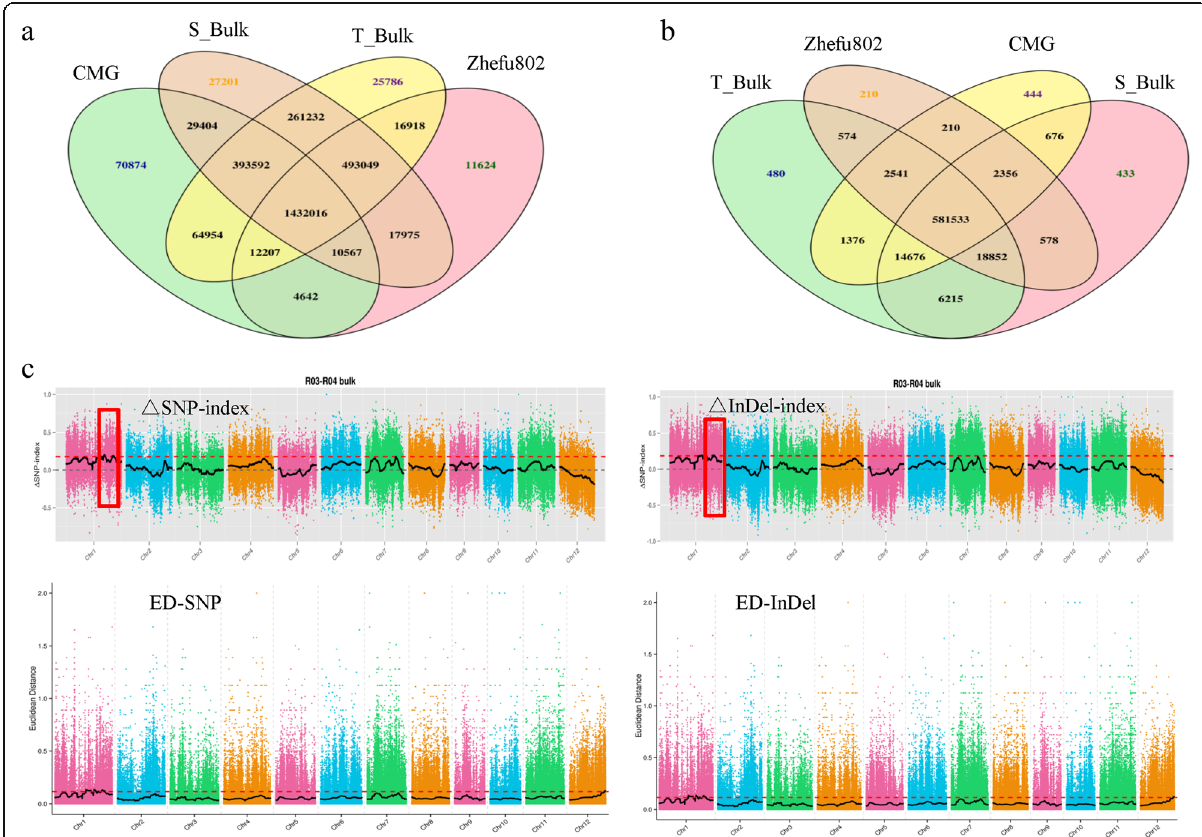
Fig. 2 Constructing the extremely sensitive (S_bulk) and tolerant (T_bulk) salt bulks and BSA-seq analysis for both parents, CMG and Zhefu802, and the two extreme bulks. a : The frequency distribution of the germination rate in more than 1000 F 2:3 lines from CMG and Zhefu802; b : Venn diagram of the number of SNPs in CMG, Zhefu802, S_bulk, and T_bulk; c : Venn diagram of the number of small InDels in CMG, Zhefu802, S_bulk, and T_bulk; d : the distribution of associated values based on SNP − /InDel-index and Euclidean Distance (ED) on different chromosomes